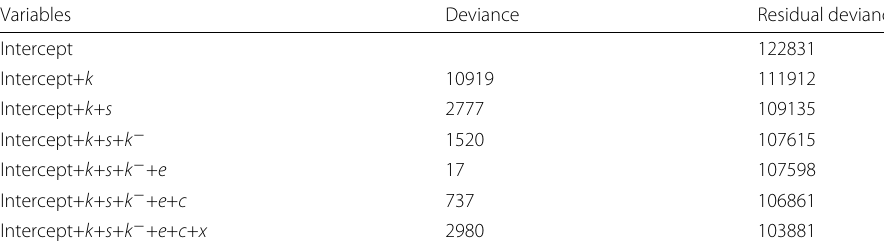
Table 7 Analysis of